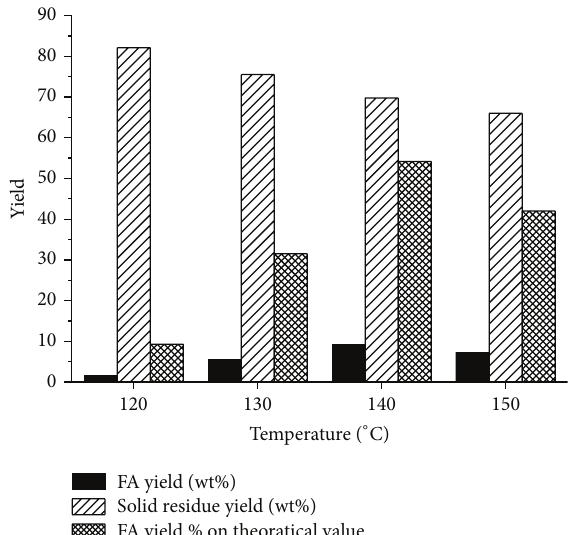
Figure 7: FA ponderal yield (wt%) [black], FA yield % on theoretical value [dense] and solid residue ponderal yield (wt%) [sparse] as a function of the hydrolysis temperature, both evaluated with respect to the starting giant reed sample (on dry basis). Reagents and operating conditions: 0.35 g of biomass, 0.20 mL of HCl 37wt%, and 5.0 g of water. Hydrolysis time = 15 min, ramping time = 5 min. All tests were performed in a CEM Discover S-Class MW reactor.